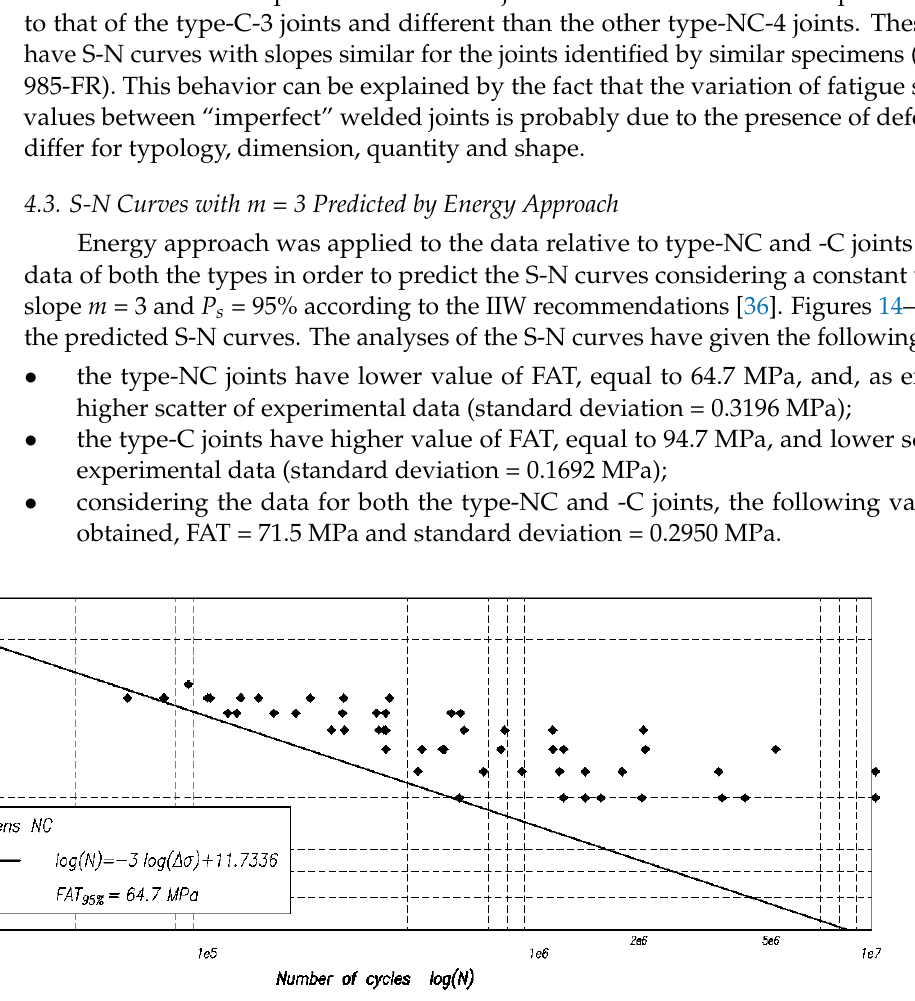
Figure 14. S-N curve with m = 3 for welded joints with defects (type-NC specimens).